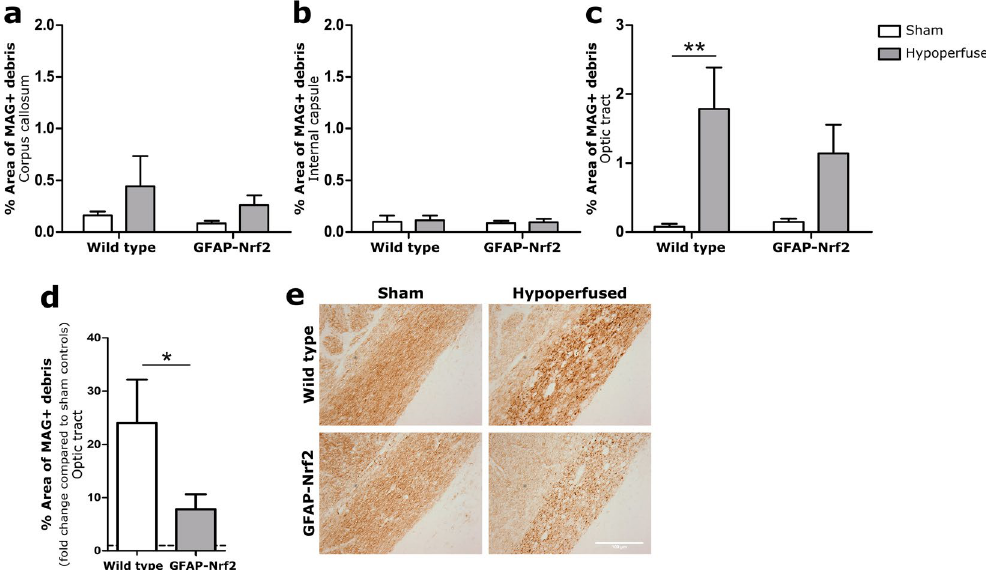
Figure 3. Loss of white matter integrity in response to hypoperfusion. ( a ) There was no significant loss of white matter integrity between groups in the corpus callosum, ( b ) nor in the internal capsule ( c ) but there was a significant effect of cerebral hypoperfusion in the optic tract (F (1,31) = 13.57, p = 0.001). ( d ) Fold change of white matter integrity loss compared to respective sham controls in the optic tract showed significantly more loss in wild type animals (p = 0.03). Dashed line indicates average sham level. ( e ) Representative images of MAG + staining in the optic tract. Scale bar 100 µ m. Mean ± SEM. ( a – c ) Two-way ANOVA with Bonferroni adjustment for post hoc analysis. ( d ) Unpaired one-tailed t-test. * p < 0.05, ** p < 0.01. n = 8–10 per